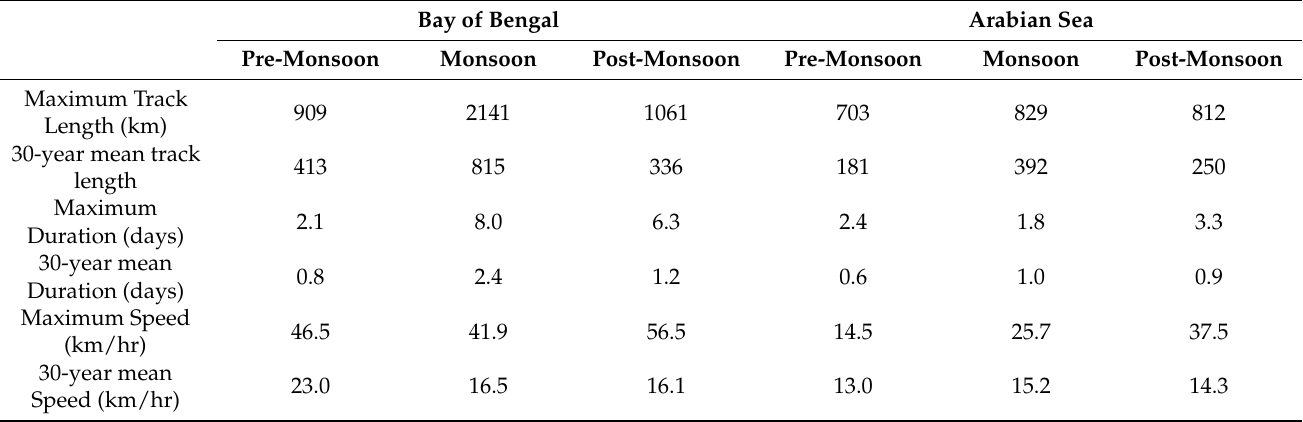
Table 2. Inland TC Length Duration and Speed after Landfall separated by monsoon